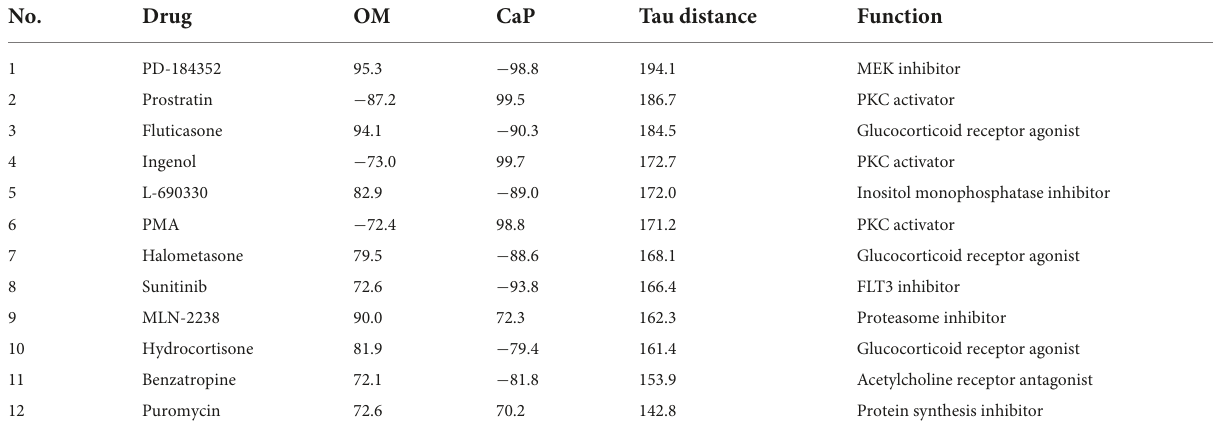
TABLE 1 Repurposable drug candidates with tau score < or > 70 sorted by the sum of tau scores in osteogenic media (OM) and calcium phosphate media (CaP) gene signature (tau distance).